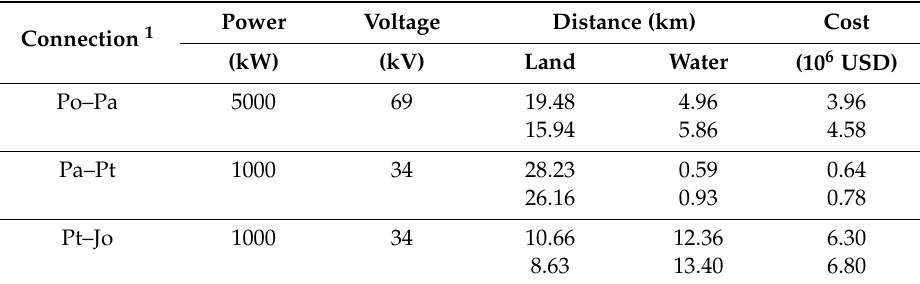
Table 6. Comparison of least-cost path generated by A* (top) and shortest path (bottom).